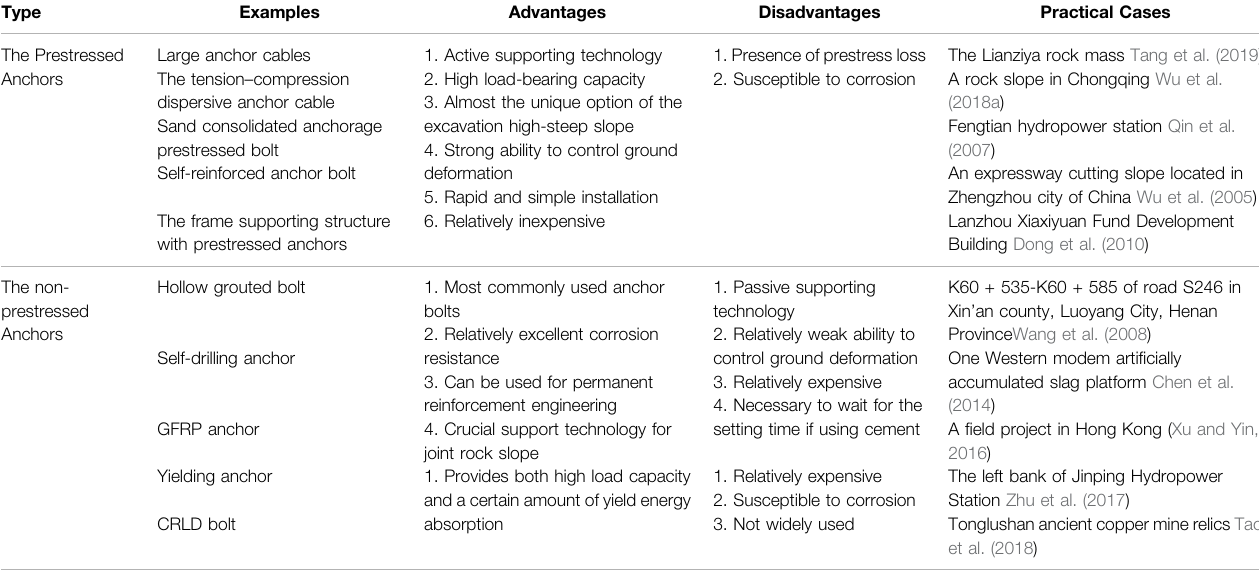
TABLE1| Summaryofthefeatures,advantages,disadvantages,examples,andpracticalcasesofsomegeotechnicalanchors(Siad,2001;Wuetal.,2005;Qinetal.,2007; Wang et al., 2008; Dong et al., 2010; Nie et al., 2014a; Cheng et al., 2015; Xu and Yin, 2016; Zhu et al., 2017; Wu S. G. et al., 2018; Wu X. et al., 2018; Tao et al., 2018; Mak et al., 2019; Tang et al., 2019; Gao et al.,